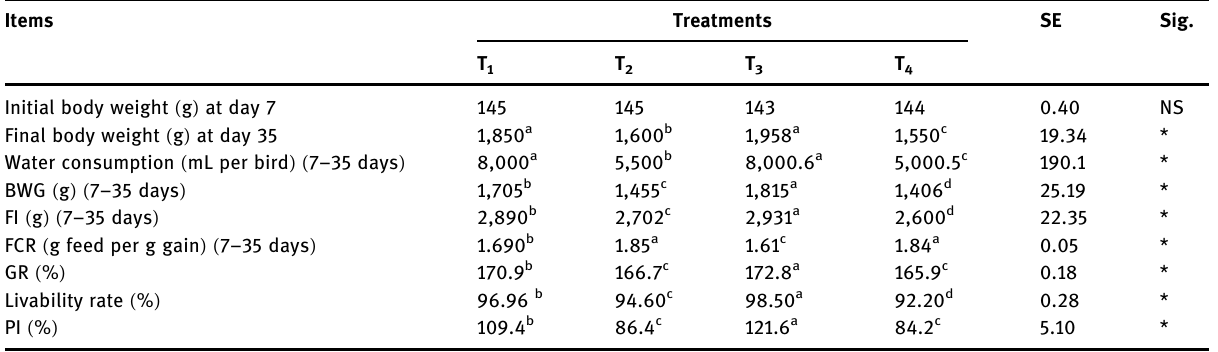
Table 2: Growth performance of broiler chickens a ff ected by using biogenic ( AgNPs ) and their NPs capping by acetic acid broiler chicken